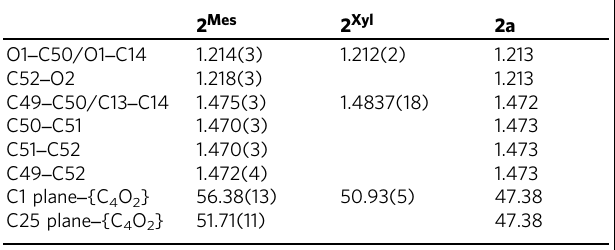
Theatomlabellingschemesfor 2 Mes and 2 Xyl aredisplayedonthecrystalstructures(Fig.1band Supplementary Fig. 2,